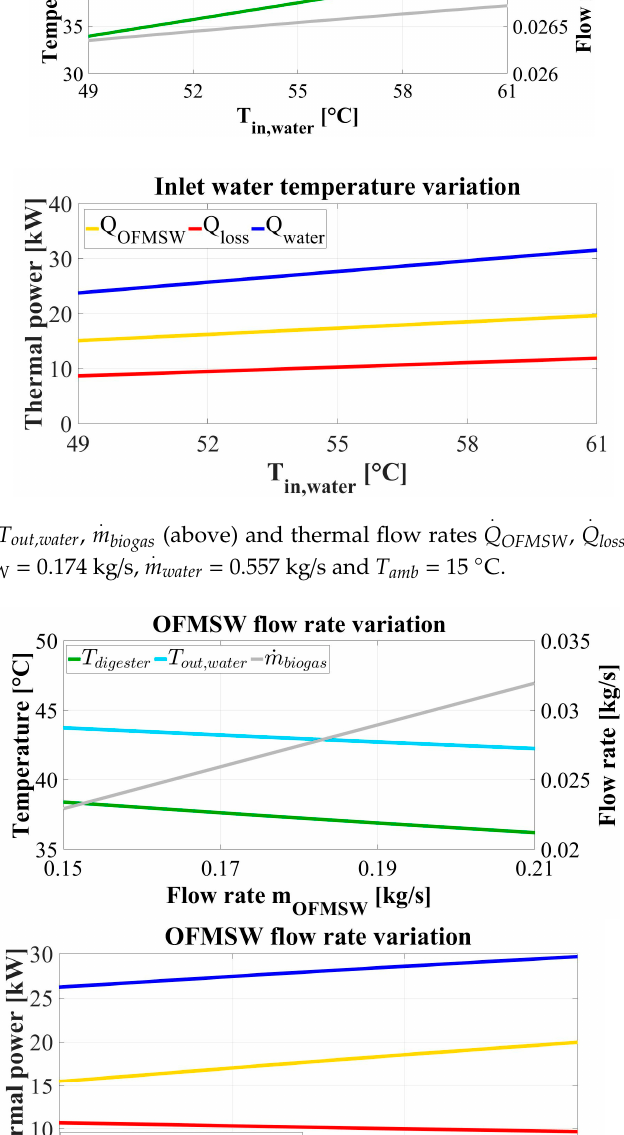
. m & (above) and thermal flow rates m biogas (above) and thermal flow rates Figure 6. T digester , T out,water , Figure 6. T digester , T out,water , biogas . . m OFMSW for m water = 0.557 kg / s, T in,water = 55 ◦ C and T amb = 15 ◦ m & for m & = 0.557 kg/s, T in,water = 55 °C and T amb = 15 °C . OFMSW water